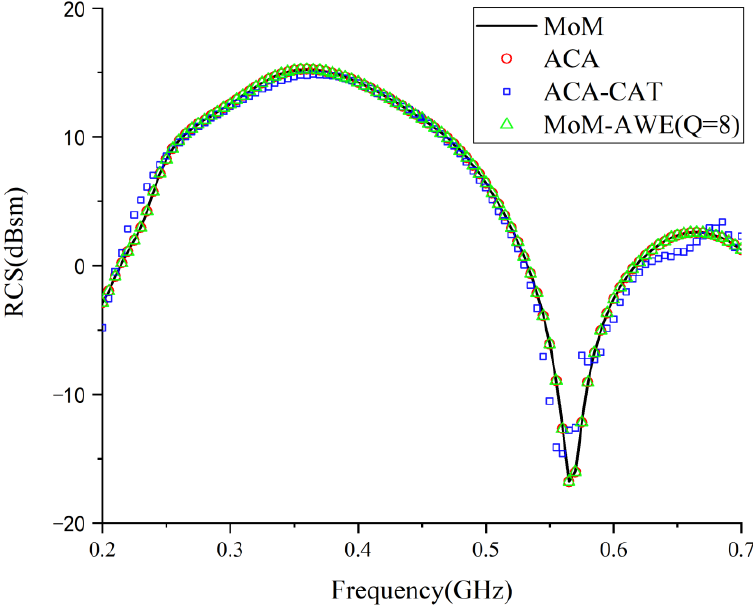
Figure 6. RCS with frequency for a four-patch array by four different methods.